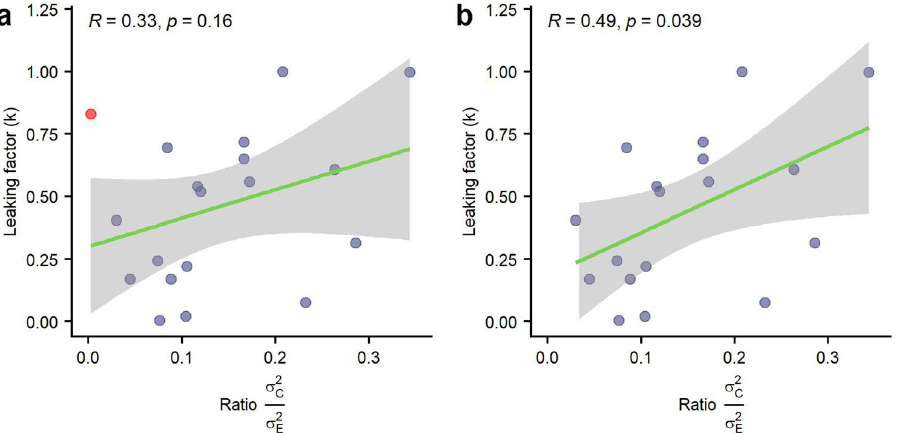
Figure 9. Correlation between leaking factor and ratio of variances. ( a ) Data from all participants with a central tendency. An outlier participant is highlighted in red. ( b ) Same correlation excluding the outlier